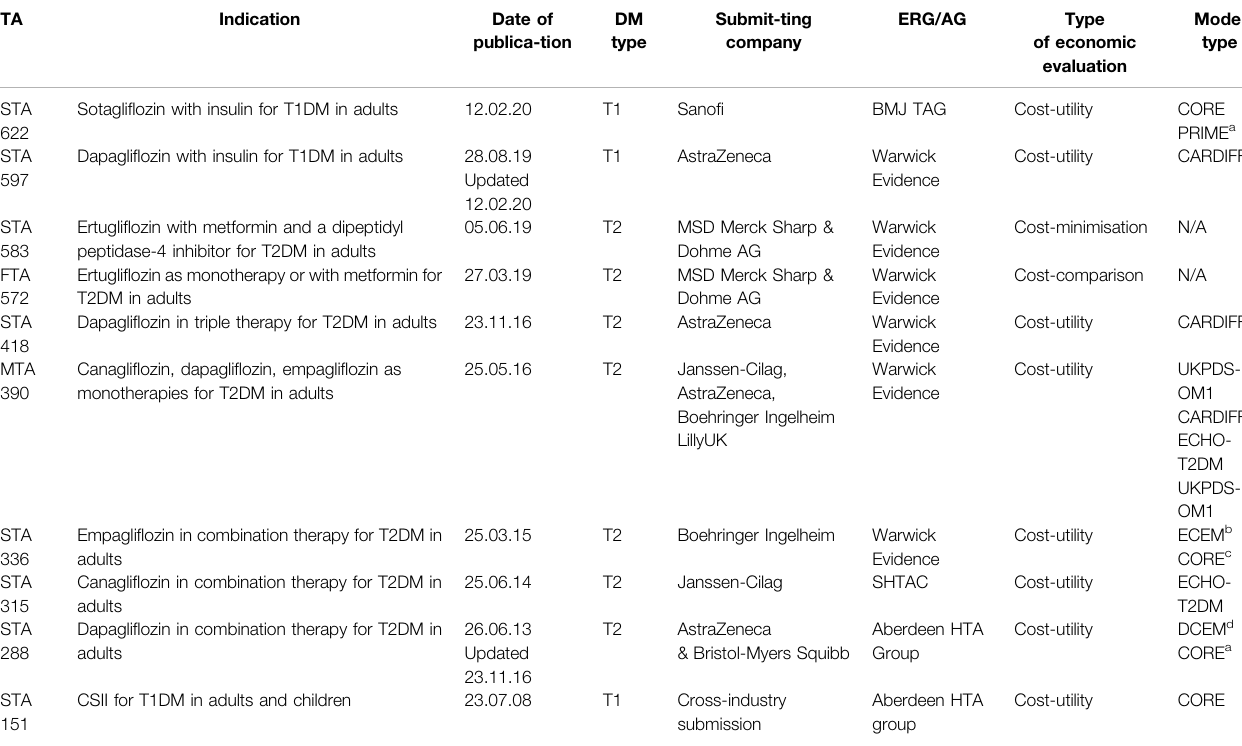
TABLE 1 | List of the technologies submitted to NICE for technology appraisal, for the treatment of T1DM and T2DM.